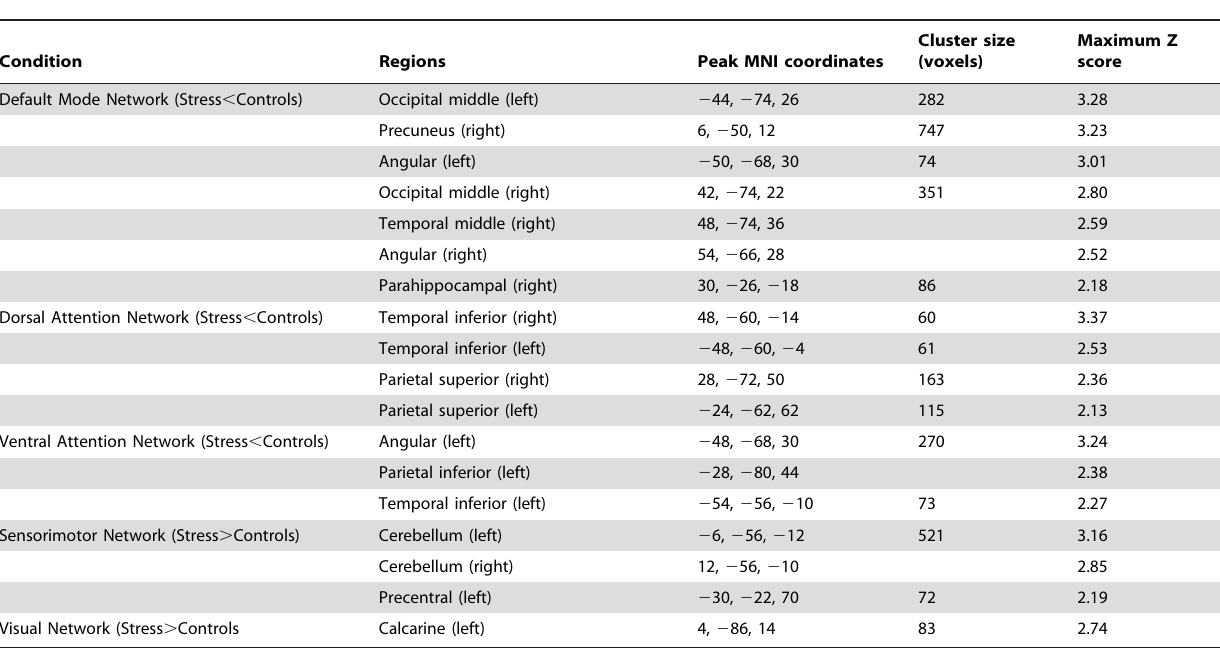
Figure 3. The impact of stress in Resting State Networks (RSNs) during task-induced deactivations. The images illustrate areas of increased deactivation in controls when compared to stressed participants in the default mode network (DMN) (A), dorsal attention network (DAN) (B), ventral attention network (VAN) (C), sensorimotor network (SMN) (D) and visual network (VN) (E), extracted by general linear model analysis and using two-sample t-tests, with results considered significant at a corrected for multiple comparisons p , 0.05 threshold. Importantly, no areas of increased deactivation of these RSNs were found in stressed individuals when compared to controls. doi:10.1371/journal.pone.0066500.g003 Table 2. Group Differences (Stress , Control) in brain regions of the DMN, DAN and VAN maps in task-induced deactivation (two sample t-tests, corrected for multiple comparisons, p ,